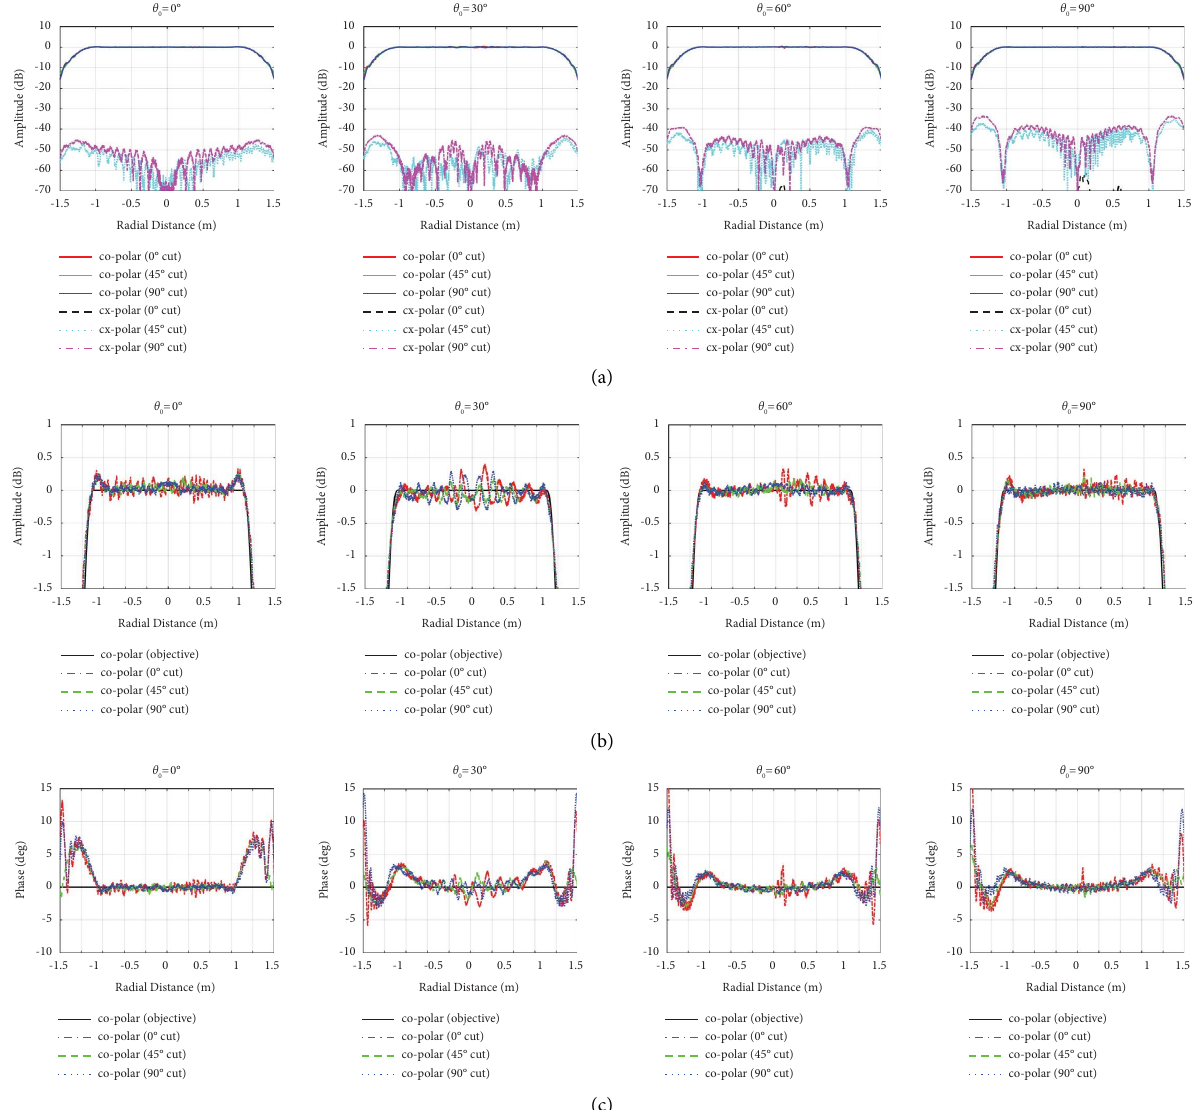
Figure 6: PO +PTD one-dimensional normalized simulation results of the designed tri-refector CATRs with diferent feed rotation angles at 100GHz. (a) Cross-polar isolation, (b) copolar amplitude, and (c) copolar